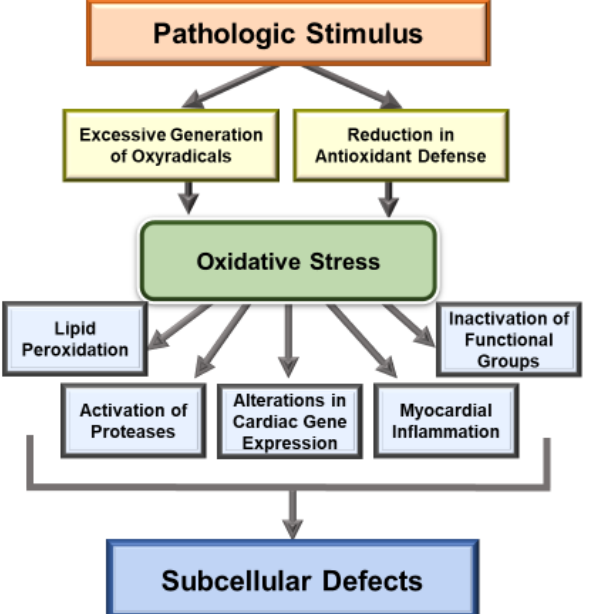
Figure 1. Mechanisms of oxidative stress induced defects in the function of subcellular organelles.